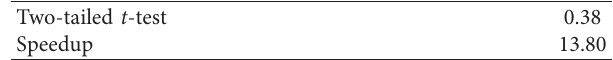
Sequentialization 16,090.00 Table 6: Two-tailed t -test and speedup results from the comparison of the sequentialization model and the multipopulation model on the case study.